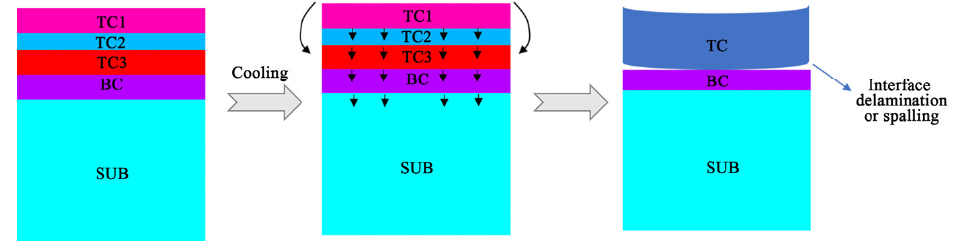
Figure 5. Failure mechanism of the coating when cooling to room temperature.